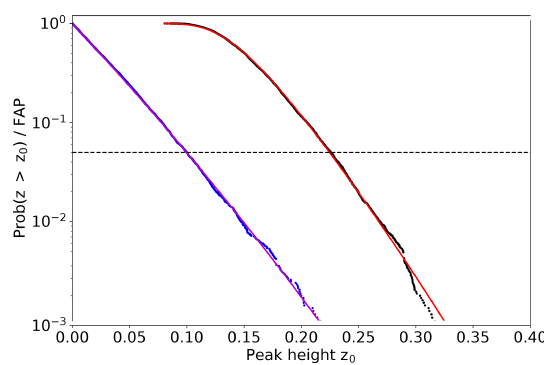
Figure 2. False alarm probability (FAP) and Prob (z > z 0 ) at a single frequency derived from 10000 noise samples with 60 data points each. The data sampling was 1d − 1 and the analysed fre- quency range (cid:49)f = 1 / 2–1 / 60d − 1 . The derived Prob (z > z 0 ) is shown with blue circles and the theoretical curve (Eq. 4) is depicted in magenta. The determined FAP is shown by the black circles and the fit to these data points using Eq. (5) is displayed as red curve. The dashed horizontal line marks a FAP of